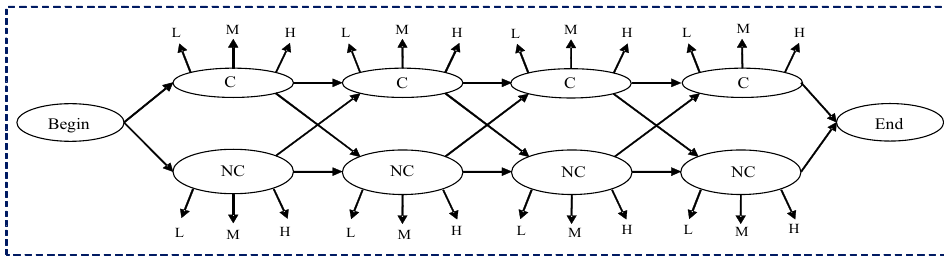
Figure 3. Illustration of Integrated Hidden Markov Calving Time Prediction Model.